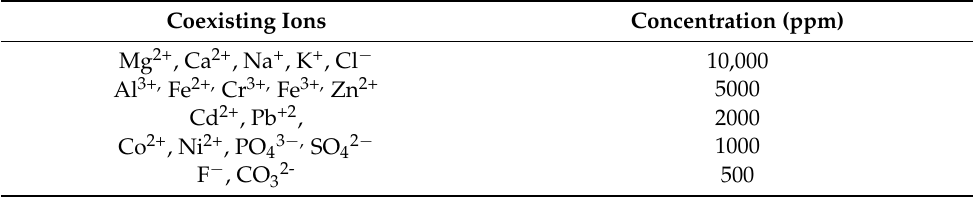
Table 3. Effect of interfering ions on Cd 2+ analytical